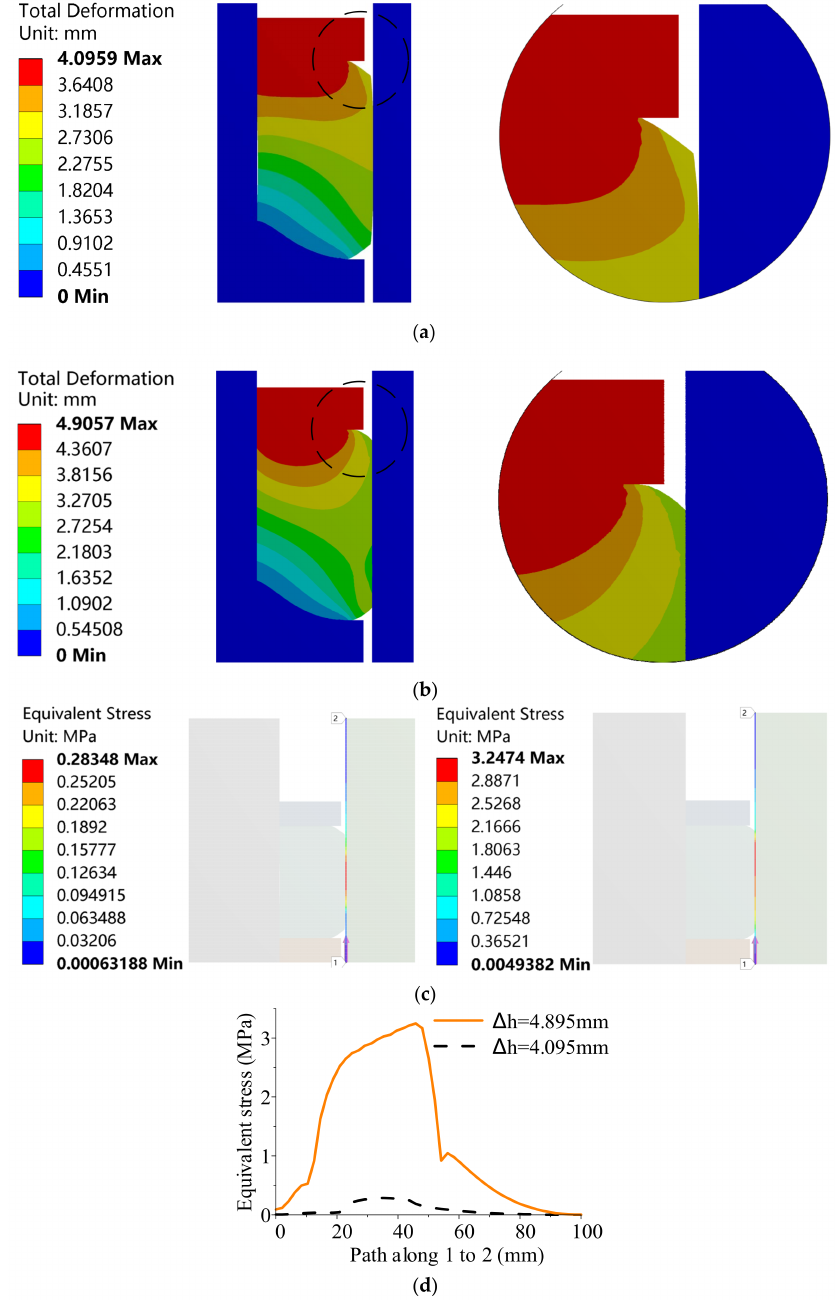
Figure 4. Diagram of compression distance of the rubber packer. ( a ) 4.095 mm compression distance; ( b ) 4.895 mm compression distance; ( c ) Equivalent stress comparison along path 1 to 2; ( d ) Equivalent stress comparison along path 1 to